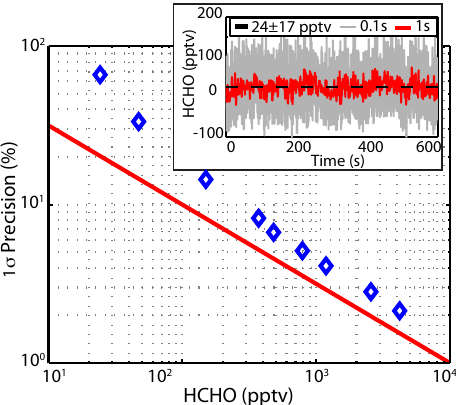
Figure 8. This plot shows the measured and theoretical 1 σ preci- sion as a percentage of HCHO concentration. The inset shows an example of the mean and standard deviation for constant HCHO. The average value (24pptv) and the standard deviation (17pptv) are used to determine the measured precision (70% in this case) shown by the blue diamonds. The solid line is the theoretical maximum precision based on the counting statistics of the signal